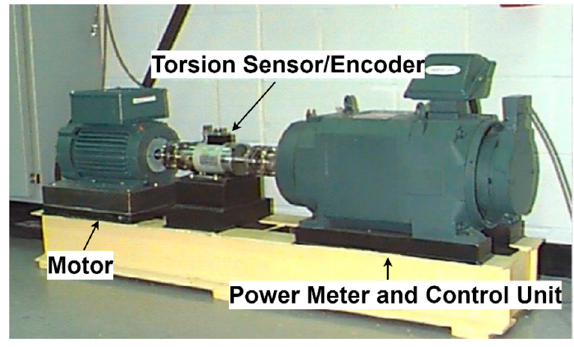
Figure 14. CWRU Bearing Failure Test Bench.